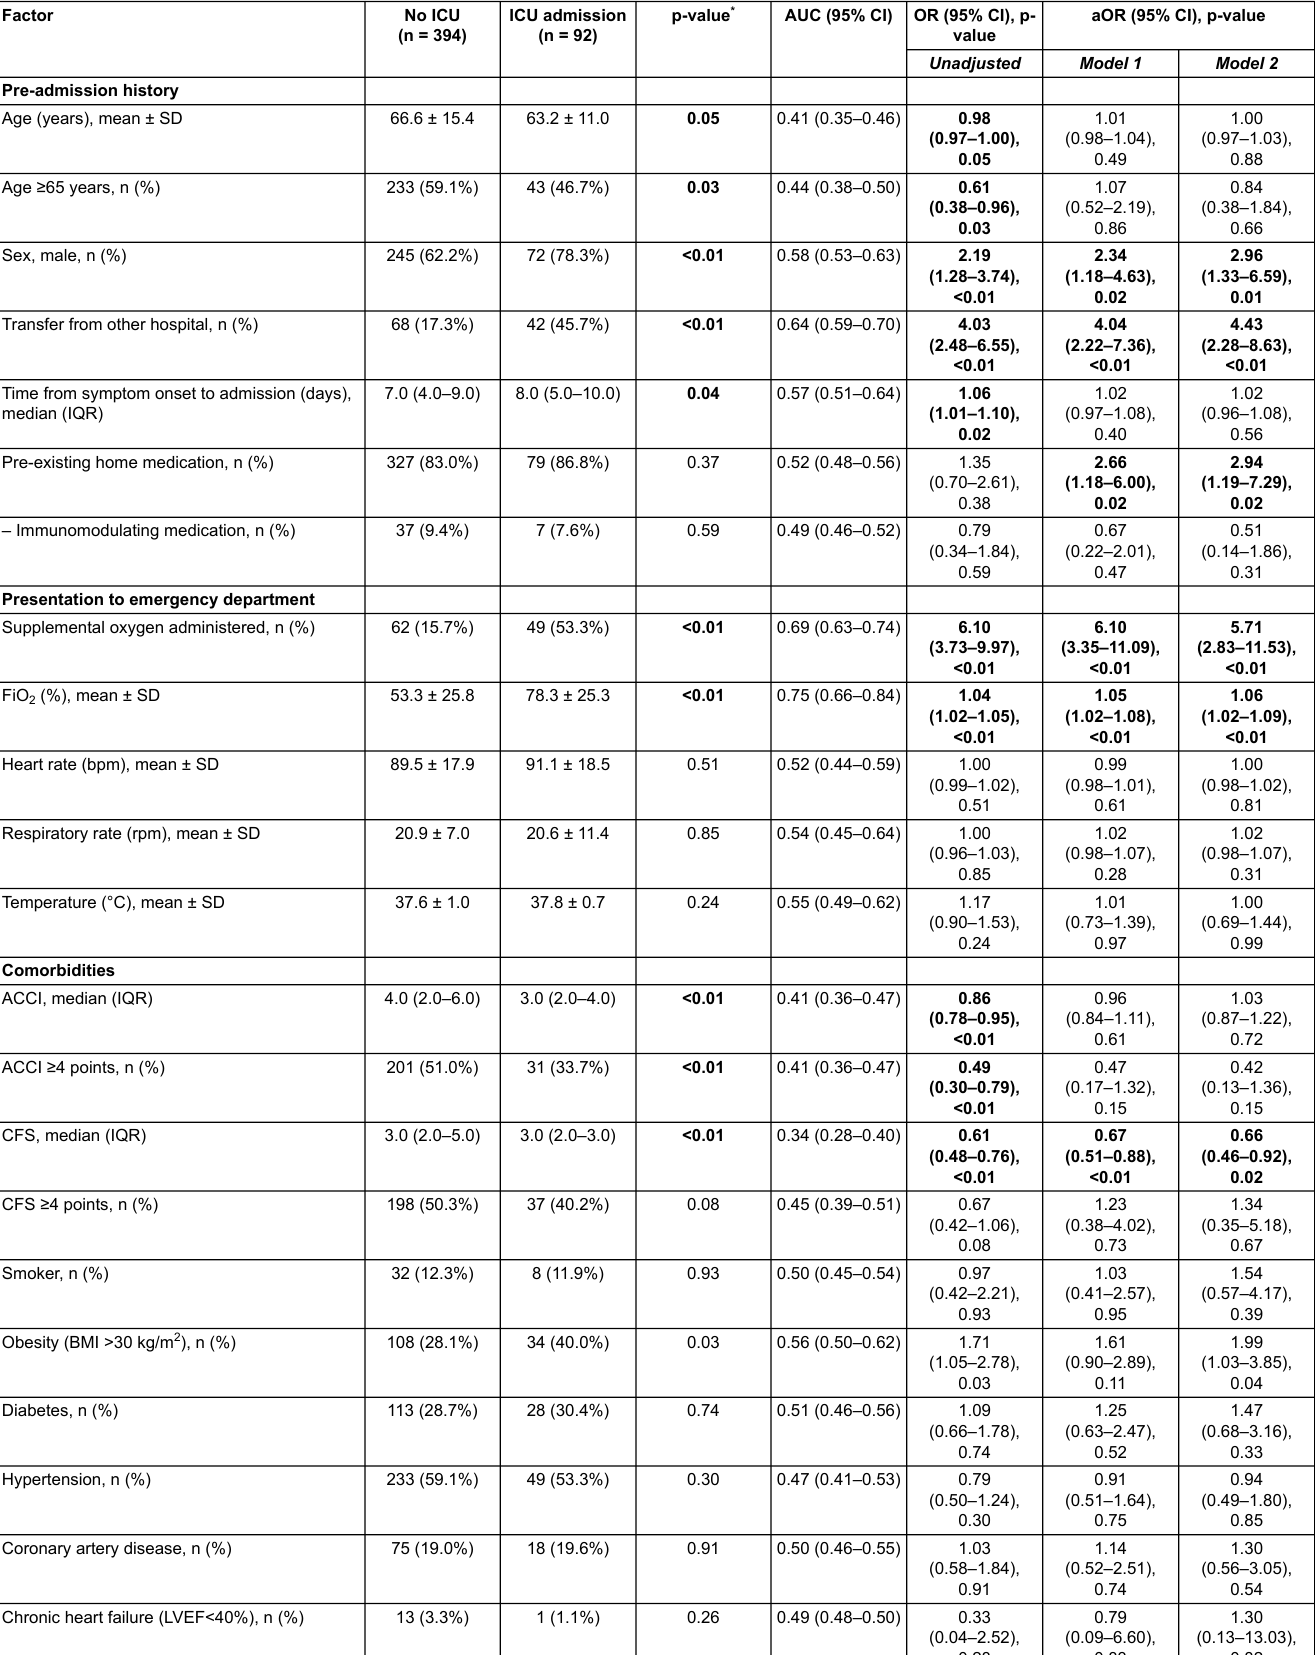
Table S3: Association and discrimination of baseline characteristics and vital signs upon admission stratified by ICU